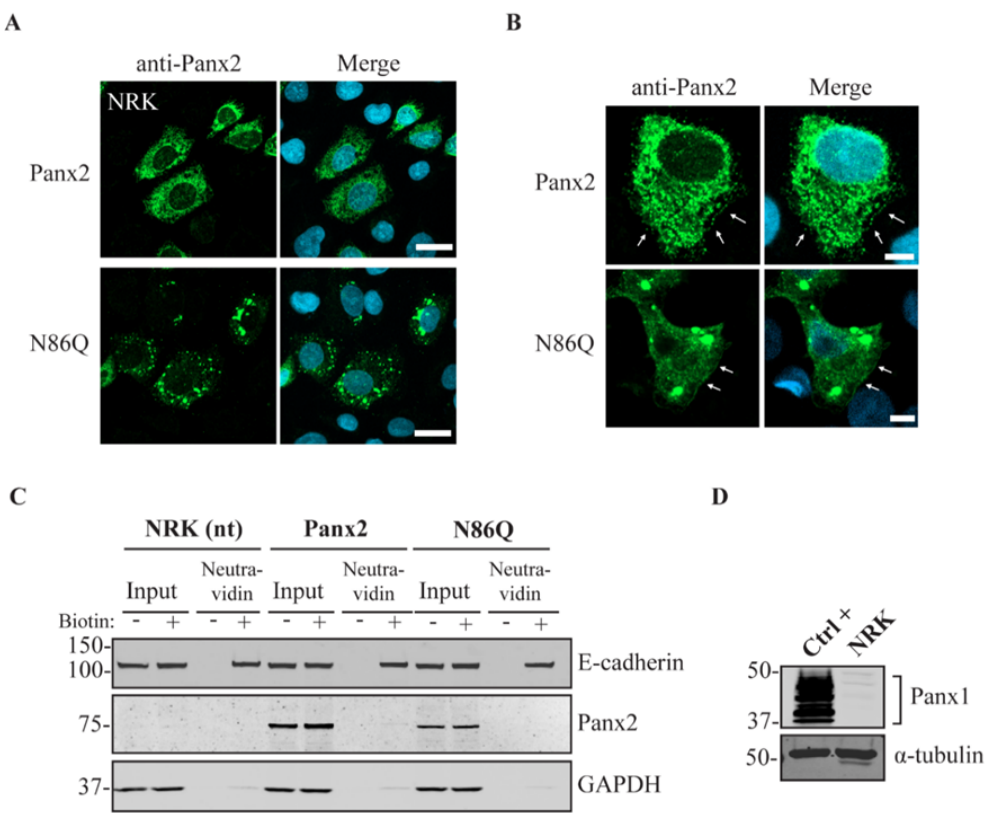
Figure 2. Panx2 has a predominantly intracellular localization, and its N-glycosylation-deficient mutant (N86Q) forms aggregates in NRK cells with low endogenous Panx1 protein expression. ( A ) Confocal micrographs of Panx2 and N86Q ectopically expressed in NRK cells, immunolabeled with anti-Panx2 antibody (green), revealed that Panx2 is predominantly localized intracellularly. The mutant N86Q is also localized intracellularly but appeared mostly as punctate aggregates. Nuclei (blue) were counterstained with Hoechst 33342. Scale bars = 20 µ m. ( B ) Representative images of a small subpopulation of NRK cells expressing Panx2 or N86Q that showed minimal apparent localization at the cell surface (indicated with white arrows). Scale bars = 5 µ m. ( C ) Western blot analysis of cell-surface-biotinylated proteins with EZ-Link™ Sulfo-NHS-SS-Biotin pulled down with NeutrAvidin ® beads showed very low detection of Panx2 but not the N86Q mutant at the cell surface of NRK cells. E-cadherin was used as a positive control of cell surface protein labeling and GAPDH was used as a negative control of intracellular proteins (no biotin internalization). Non-transfected NRKs (nt) were used as a negative control. ( D ) Western blot of protein lysate from NRK cells indicated that these cells have very low detectable levels of endogenous Panx1. Overexpressed Panx1 was used as positive control (Ctrl +) and endogenous α -tubulin was used as protein loading control. Molecular weights noted in